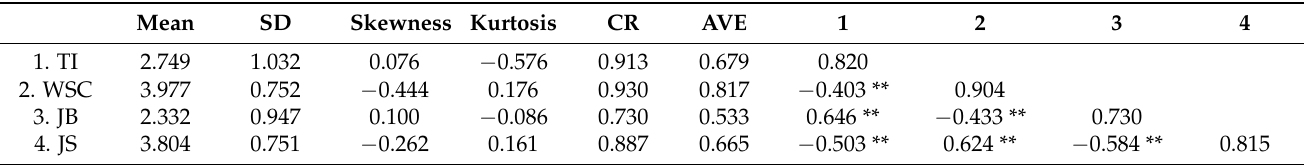
Table 2. Psychometric properties and correlations among the latent